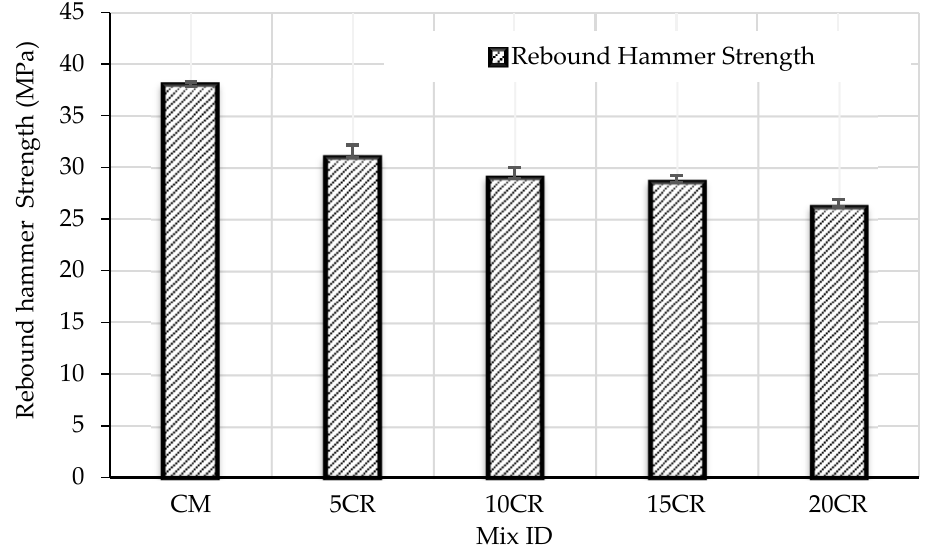
Figure 16. Rebound hammer test results.